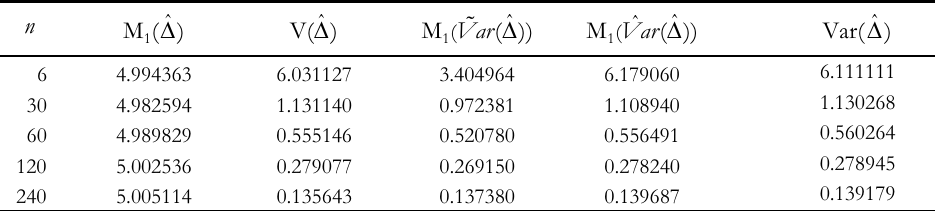
Simulation data for the estimation of ˆ Var( ) (cid:39) by and sampling from the exponential distribution (B=5000